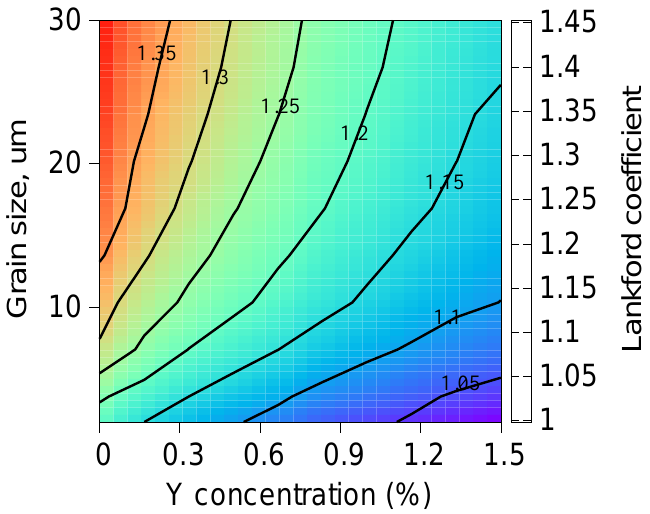
Figure 7. The model-calculated distribution of the Lankford coefficient for tension along the rolling direction (RD) in the grain size and Y-content space.